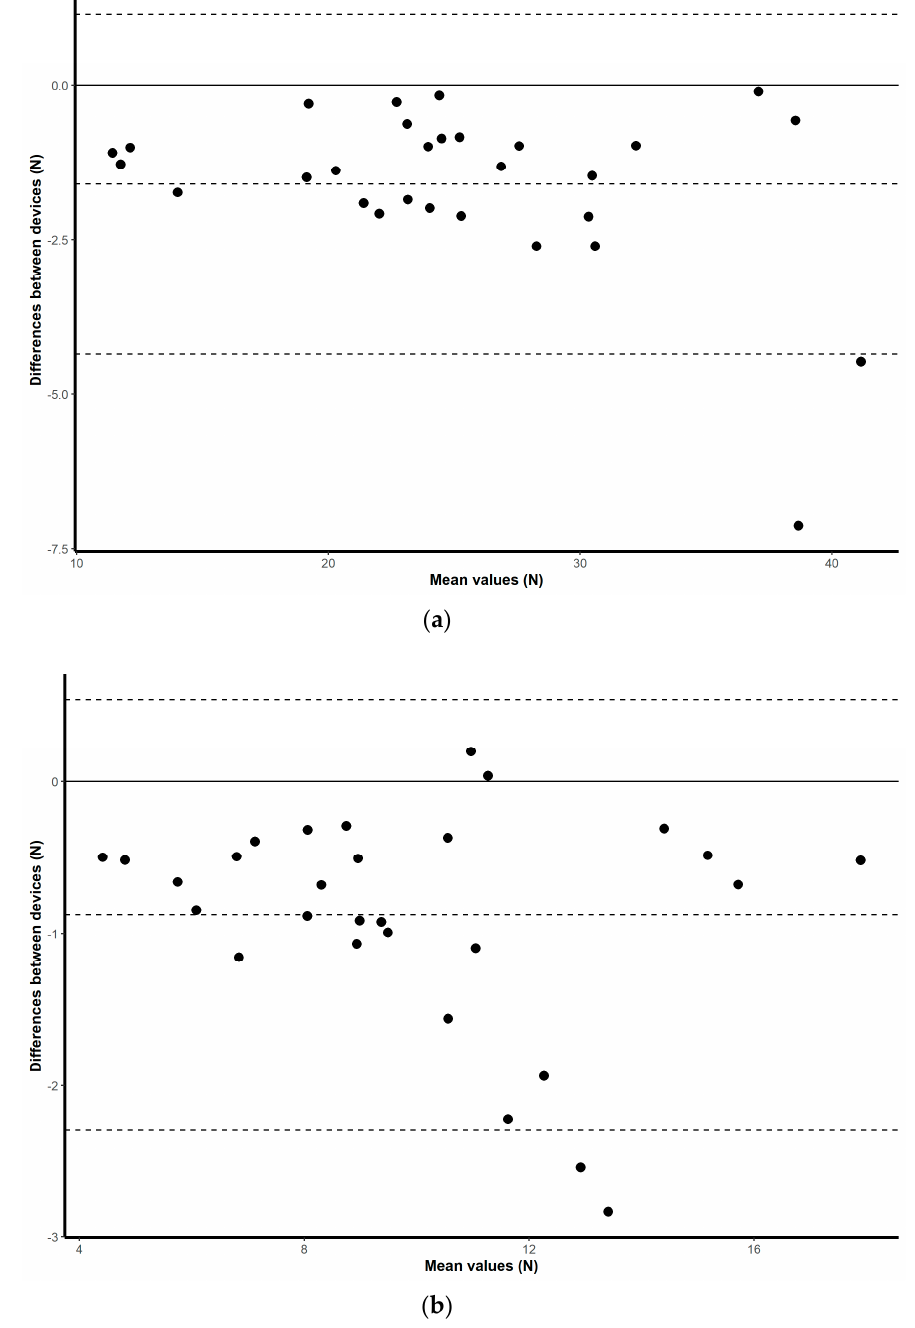
Figure 8. Session one mean difference plot comparison of the results from the HX711 microcontroller- based load cell and the signal conditioner for: ( a ) maximal isometric leg extension; ( b ) maximal isometric bicep flexion. The middle-dashed line represents the mean difference and the upper and lower dashed lines represent the 95% limits of agreement (mean ± 1.96 * SD).